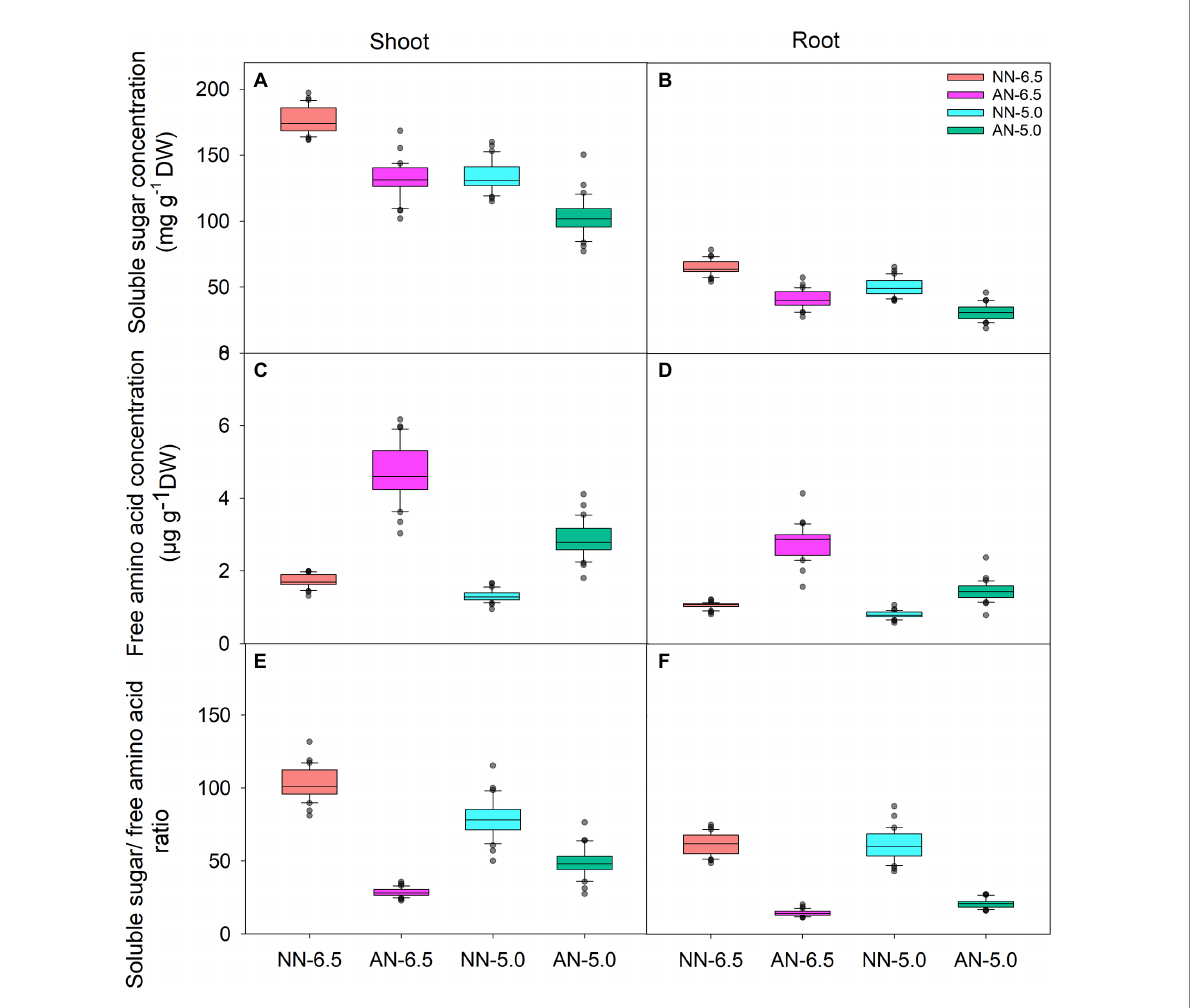
FIGURE 3 The levels of soluble sugar, free amino acids and soluble sugar/ free amino acid ratio in shoots and roots of 31 wheat cultivars grown under different N-sources and pH levels. Data are means ± SE (n = 31). NN-6.5 refers to the nitrate nitrogen at a pH of 6.5; NN-4.5 refers to the nitrate nitrogen at a pH of 6.5; AN-6.5 refers to the ammonium nitrogen at a pH of 6.5; AN-5.0 refers to the ammonium nitrogen at a pH of